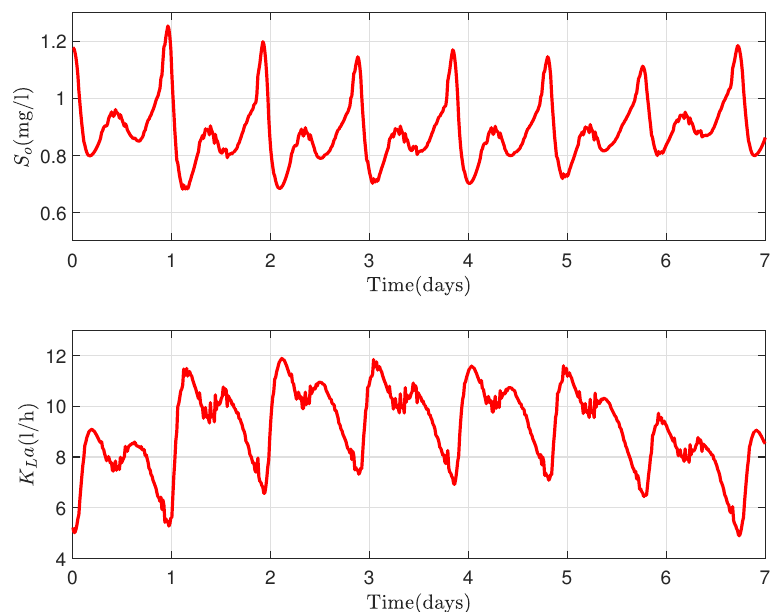
Figure 8. ( Above ): DO concentration variation and ( Below ): Aeration flow for Scenario 2.